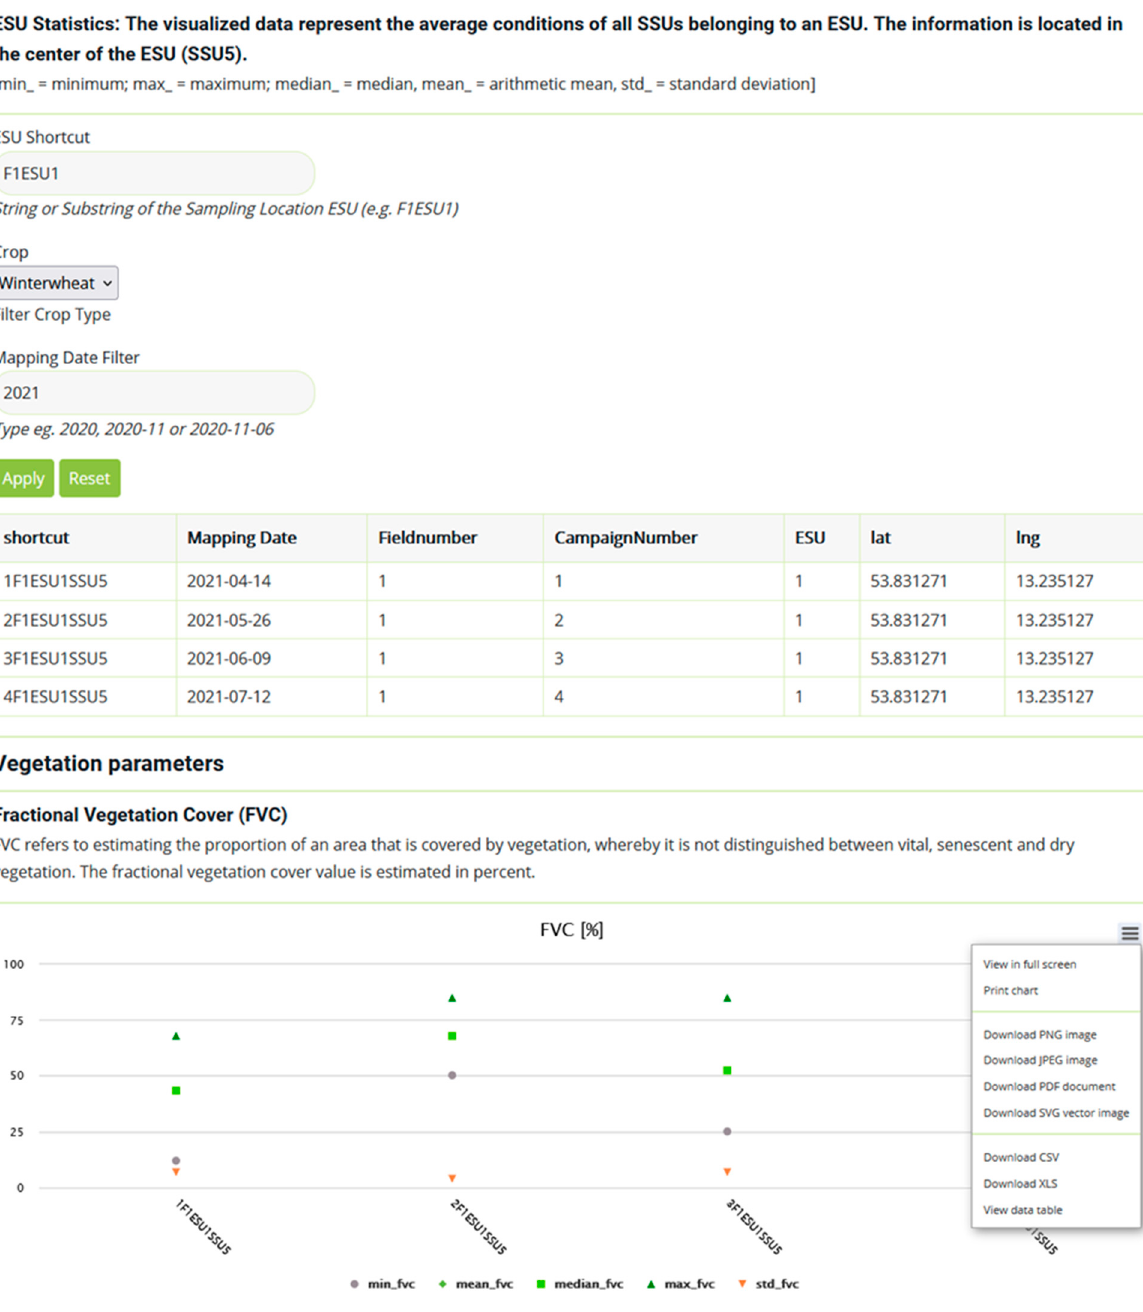
Figure 3. Visualization of aggregation of single SSUs to ESU exemplified by the Fractional Vegeta- tion Cover (FVC). Cover